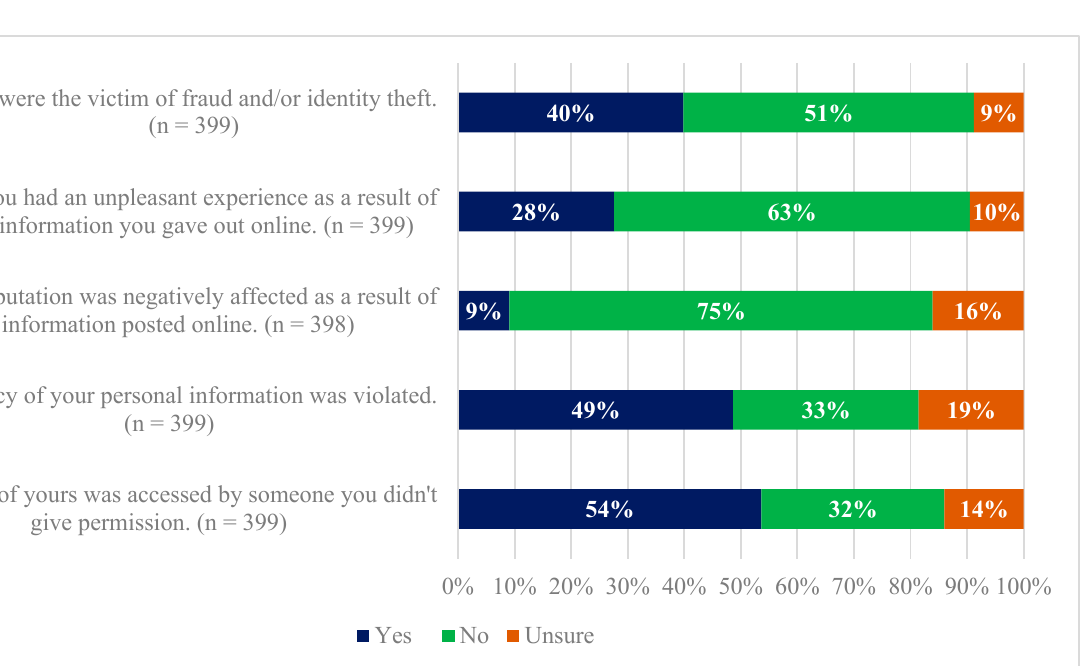
Figure 3 . Reported past personal privacy-related experiences among survey participants. Figure 3. Reported past personal privacy-related experiences among survey